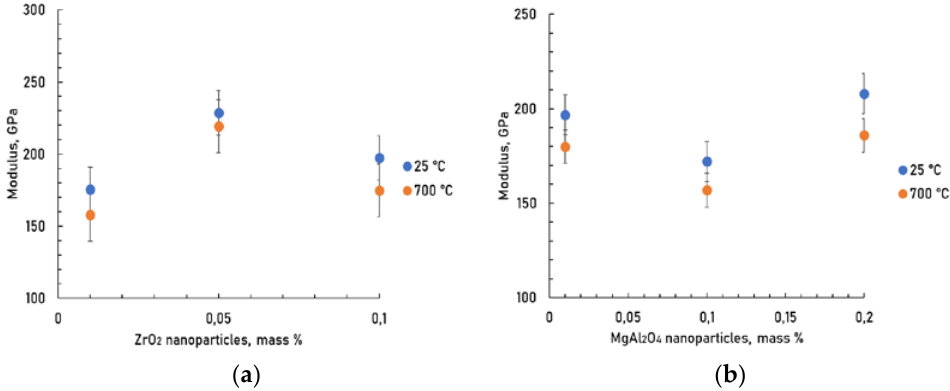
Figure 10. Young’s modulus of composites at test temperatures of 25 and 700 °C depending on the concentration of ZrO 2 ( a ) and MgAl 2 O 4 ( b ) nanoparticles.